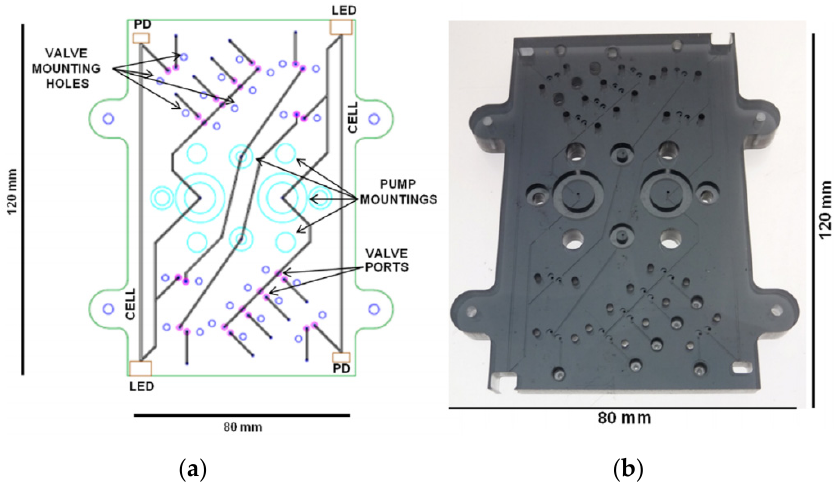
Figure 1. ( a ) Diagram of the microfluidic chip; ( b ) photograph of the tinted polymethyl methacrylate (PMMA) chip [71]. Figure reprinted with permission from Elsevier .